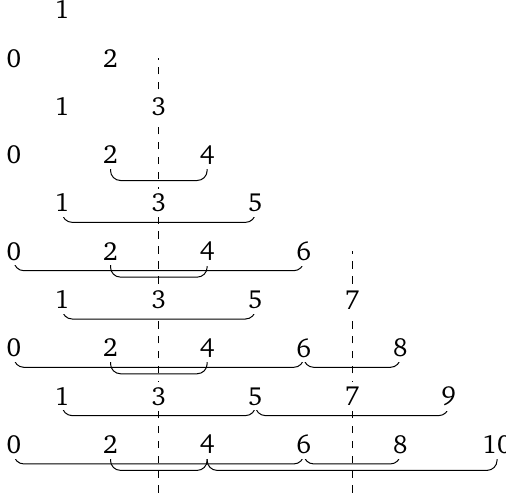
Figure 1: Bratteli diagram for TL